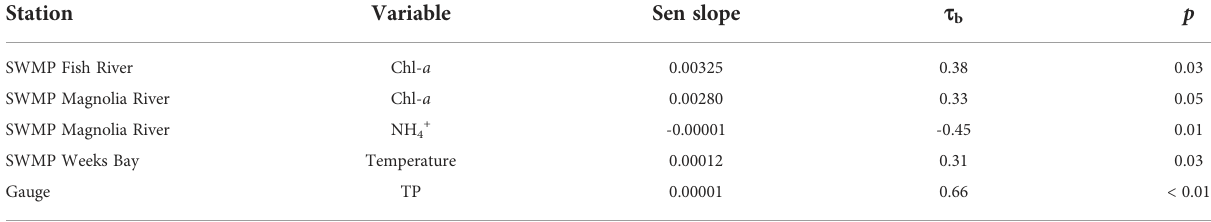
TABLE 3 Sen slopes and t b for variables with signi fi cant ( p < 0.05) Mann Kendall monotonic trends at SWMP stations and the